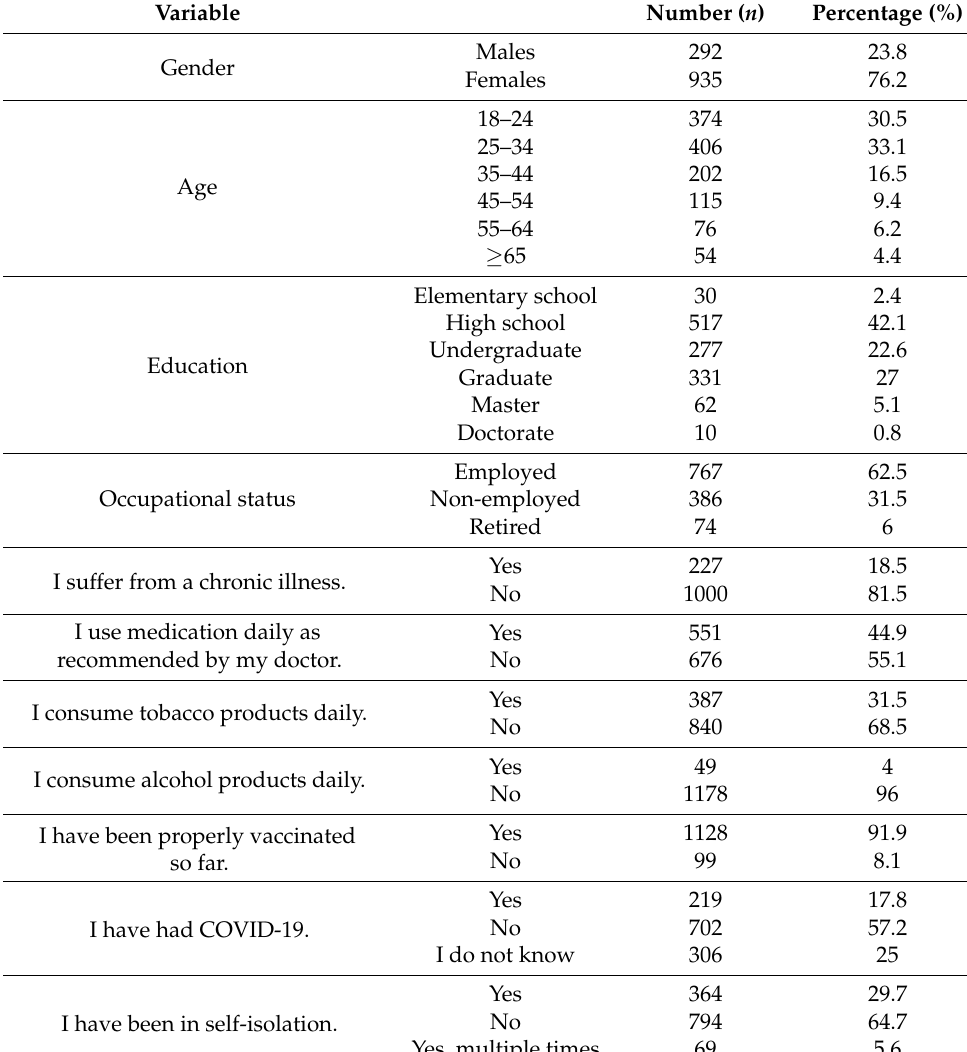
Table 1. Demographic characteristics of the participants ( n =